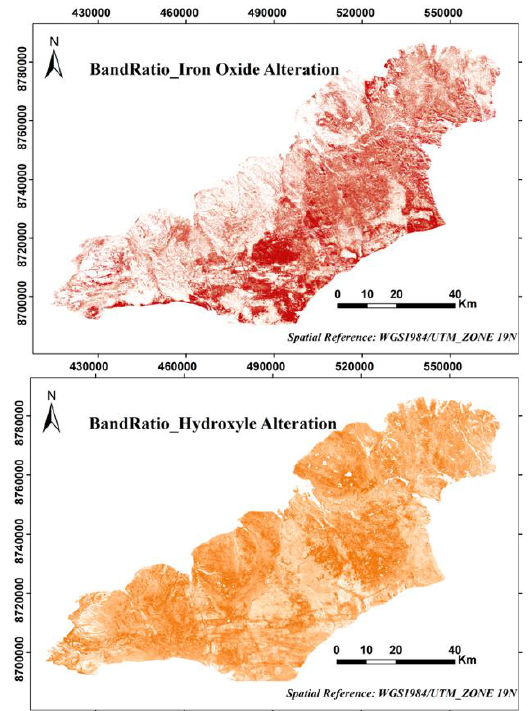
Figure 3. FeO and OH alteration maps based on band ratio techniques; pixels with high colour intensity mark target areas.